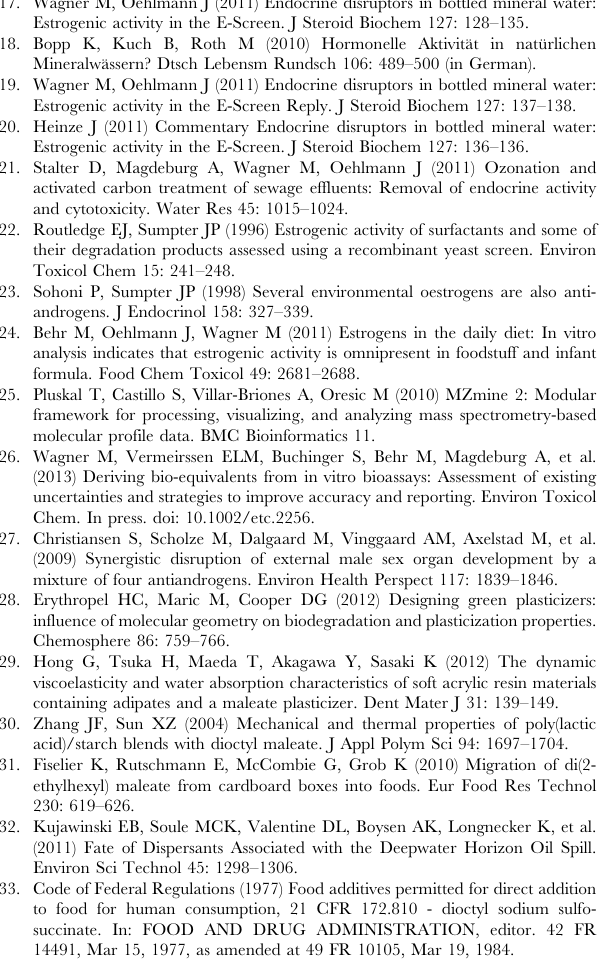
Table S4 Compounds with an exact mass of 363.25047 [M + Na] + and consistent in silico and experimental fragmentation. Table S5 Parameters for confirmation studies via LC- tandem